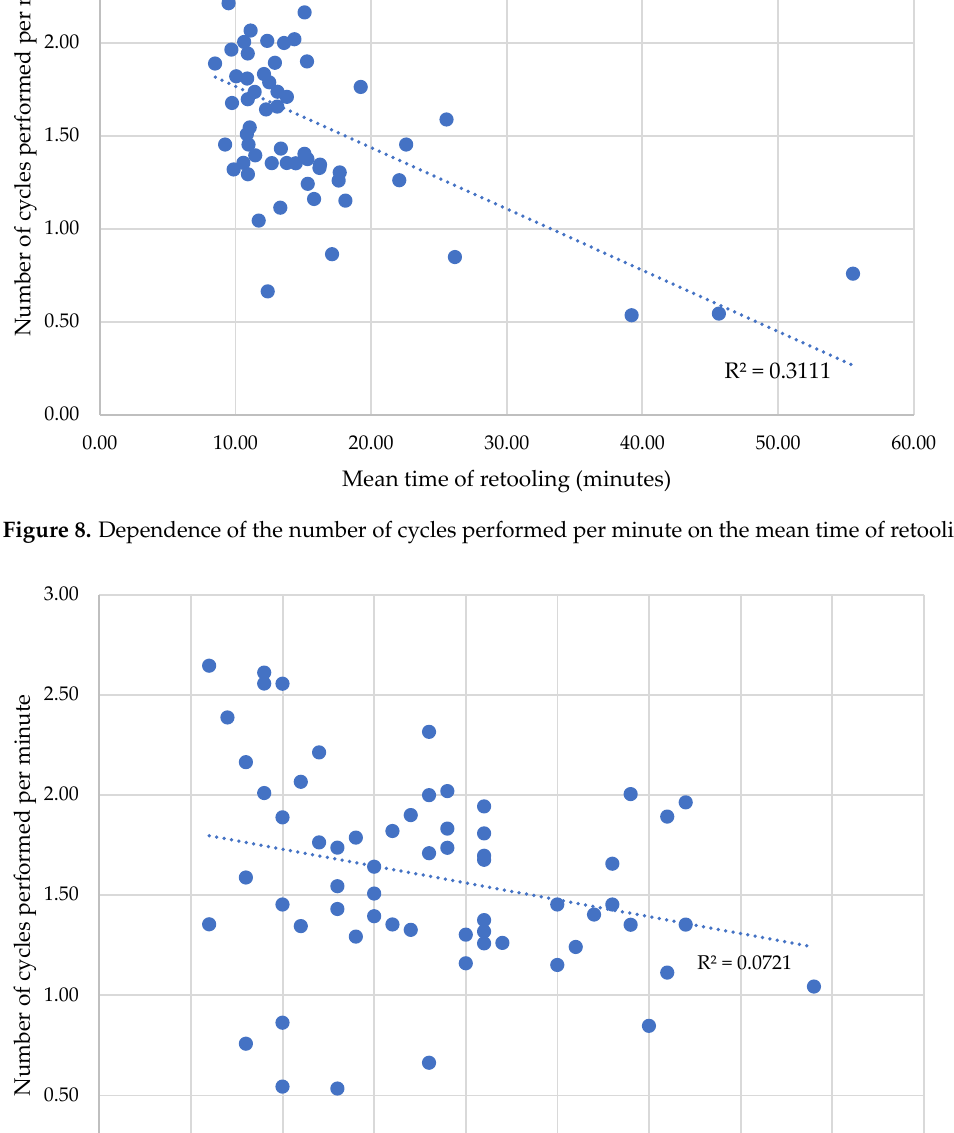
Figure 9. Dependence of the number of cycles performed per minute on the number of retoolings.